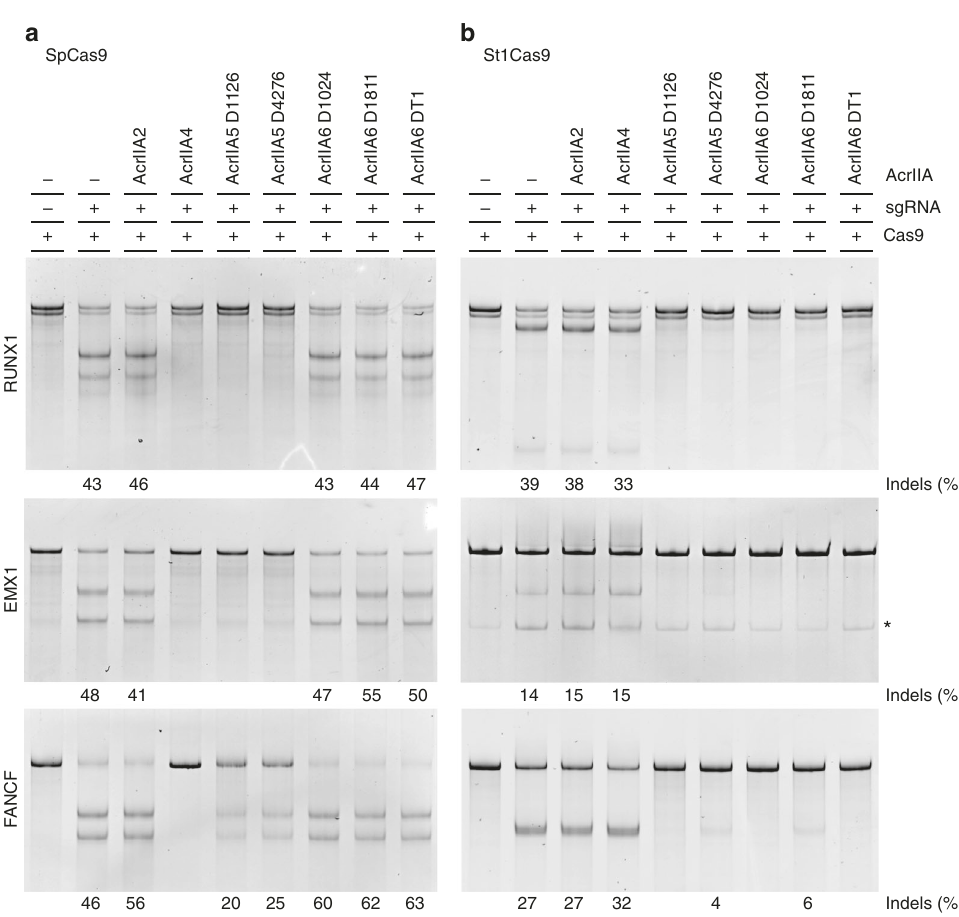
Fig. 5 Anti-CRISPR activity of AcrIIAs against SpCas9 and St1Cas9 in human cells. a K562 cells were transfected with a dual SpCas9 and sgRNA expression plasmid (500 ng) targeting RUNX1 , EMX1, or FANCF . Where indicated, a second vector (500 ng) was used to co-express human codon-optimized AcrIIAs. The Surveyor assay was performed 3 days later to determine the frequency of indels, as indicated at the base of each lane. b Same as in a but cells were transfected with an St1Cas9 expression vector (500 ng) in addition to an sgRNA expression plasmid (800 ng). ( − ) Indicates that the transfection mix contained the same amount of a related empty vector. * Indicates a non-speci fi c band co-migrating with the speci fi c cleavage